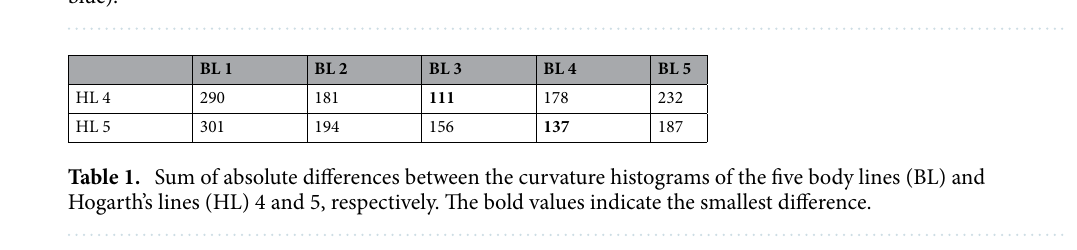
Figure 6. Curvature histograms (scaled to percent) of the five body lines (in red) and Hogarth lines 4 and 5 (in blue).